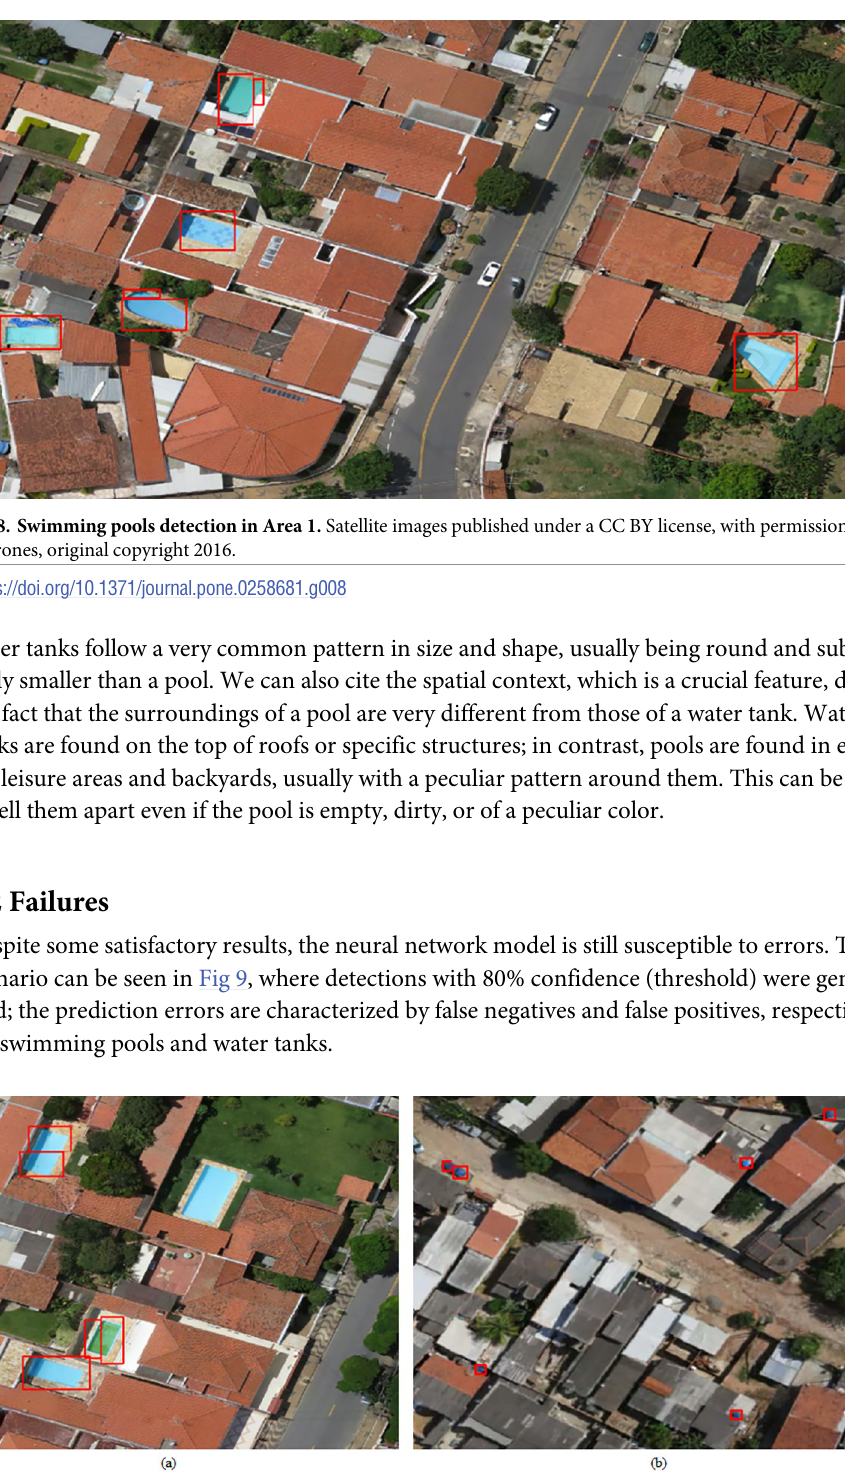
Fig 9. Prediction errors-false negatives and false positives. In (a) there is a swimming pool that was not detected, and in (b) a blue car was detected as a water tank. Satellite images published under a CC BY license, with permission from G drones, original copyright